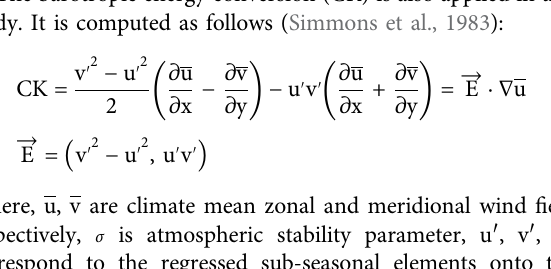
Frontiers in Earth Science |